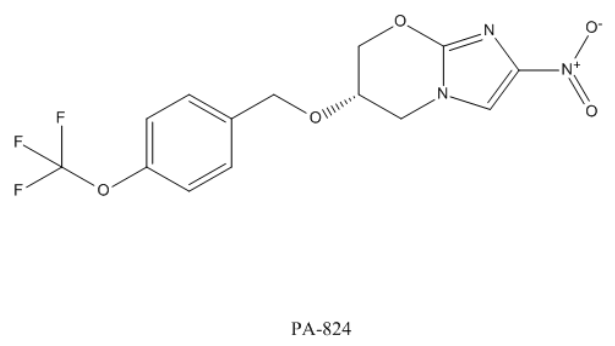
Figure 3. Structure of